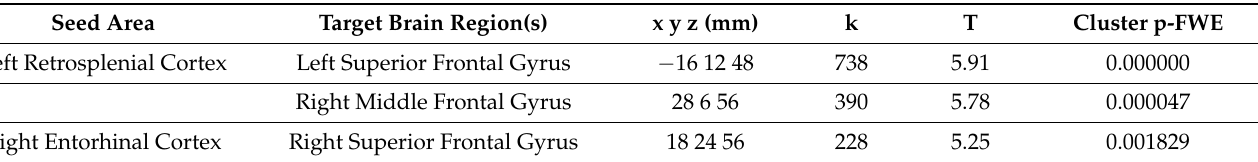
Table 2. Post training Sleep-Dependent Relearning-Related Changes in resting state seed-based FC on Day 4 (rsfMRI 4 > rsfMRI 3, SD > RS).